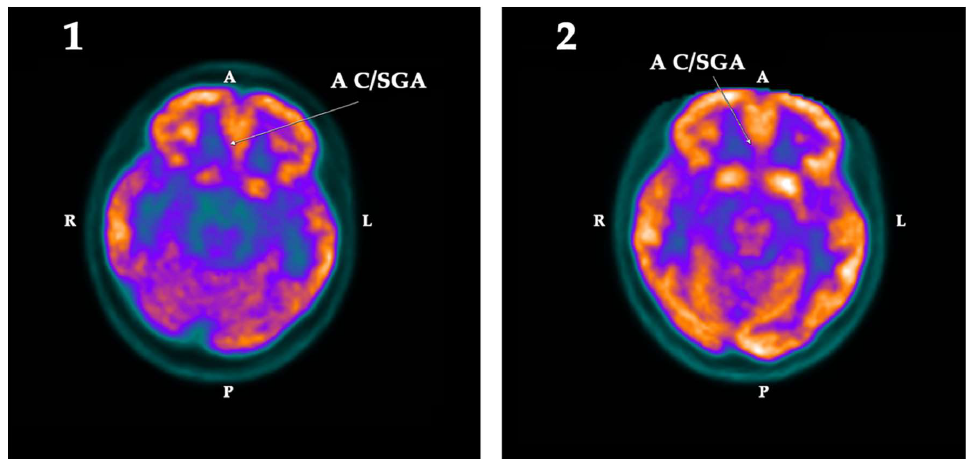
Figure 3. Cross section of the brain showing the metabolic activity in the subgenual area of the anterior cingulate cortex (A C/SGA) in the first ( 1 ) and the second ( 2 ) PET-SCAN studies. Note that the low metabolic activity observed in A C/SGA in the first PET-SCAN was normalized ( p < 0.025) after treatment with GH. A: Anterior. R: Right. L: Left. P: Posterior.